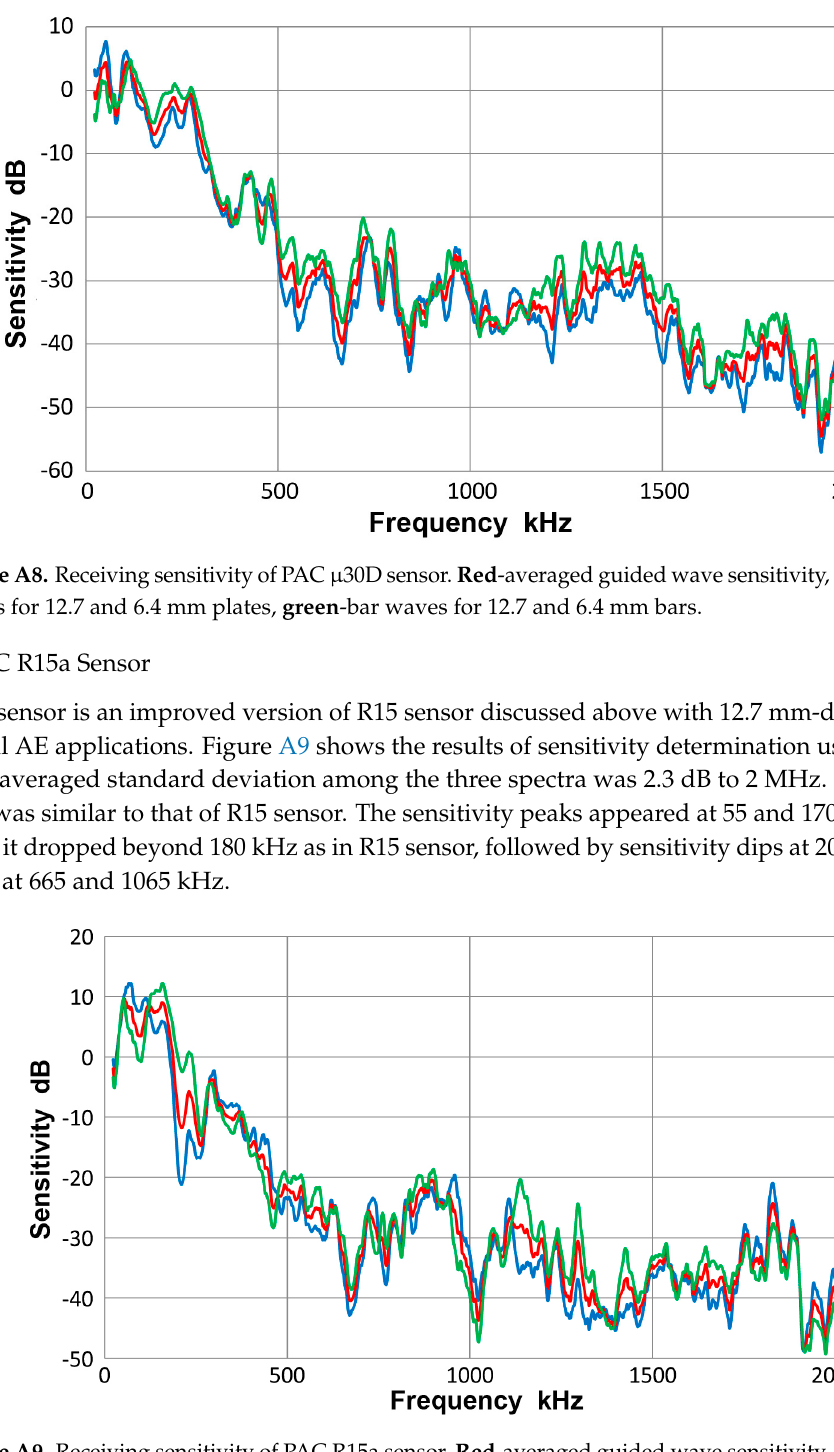
Figure A9. Receiving sensitivity of PAC R15a sensor. Red -averaged guided wave sensitivity, blue -Lamb waves for 12.7 and 6.4 mm plates, green -bar waves for 12.7 and 6.4 mm bars.